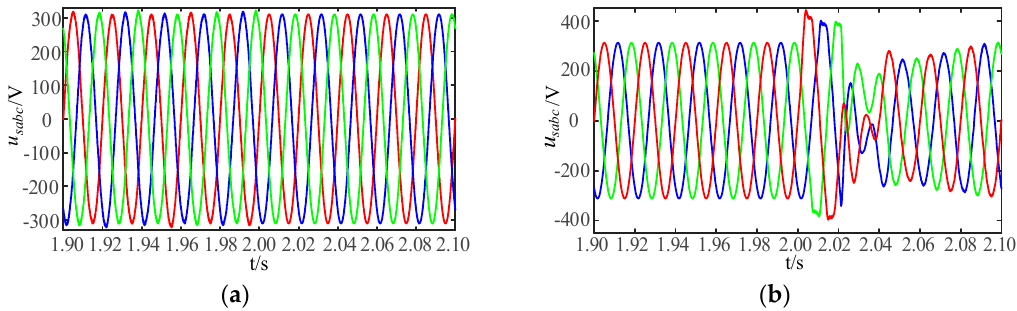
Figure 14. Mode switching results of the energy router: ( a ) Three-phase voltage waveforms of AC